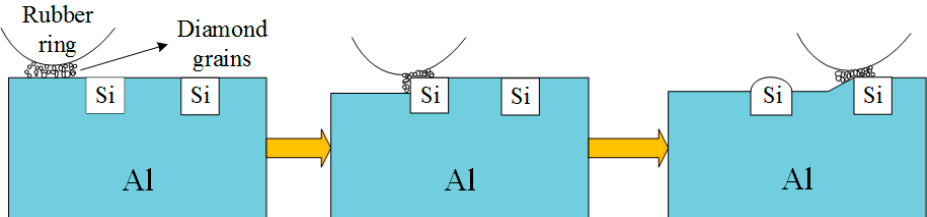
Figure 6. Mechanical honing process of the Al–Si alloy cylinder liner.